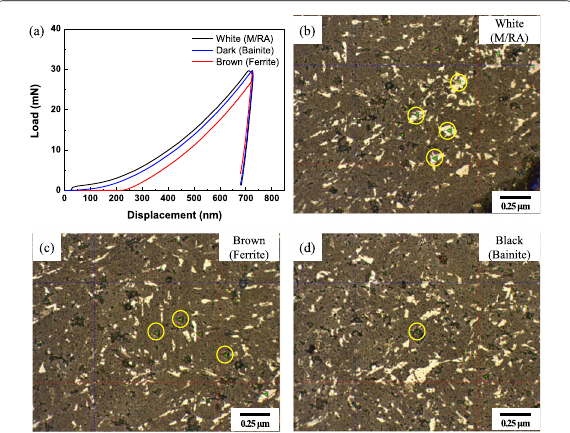
Fig. 12 Results of nano indentation testing of 4Nb specimen subjected to Final LePera etching condition. ( a ) Load-Displacement curve, ( b ) White (M/RA). ( c ) Brown (Ferrite), and ( d ) Black (bainite) phases